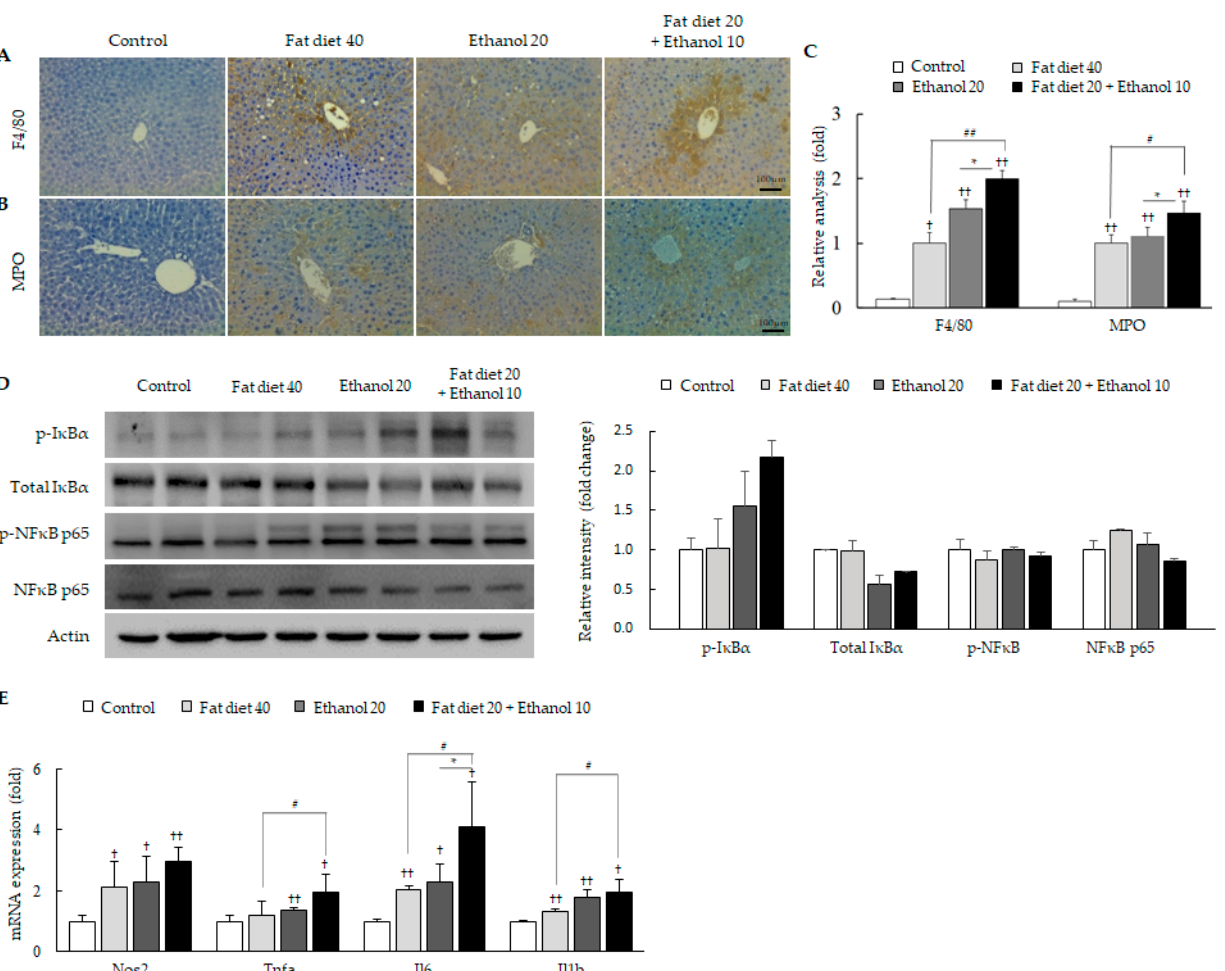
Figure 2. Inflammation phenotypes of hepatic tissues. Immunohistochemistry analysis against F4/80 ( A ) and MPO ( B ) and their quantitative analyses intensity of positive cells ( C ), fold change comparing to fat diet 40 group are presented. Western blot and relative intensity analysis of inflammatory regulator molecules ( D ) and mRNA expression levels of pro-inflammatory cytokines ( E ) are presented. Data are expressed as the mean ± SD ( n = 6). † p < 0.05 and †† p < 0.01 compared with the control group; # p < 0.05 and ## p < 0.01 compared with the fat diet 40 group; * p < 0.05 compared with the ethanol 20 group. The photograph was obtained using a light or fluorescence microscope (×200).